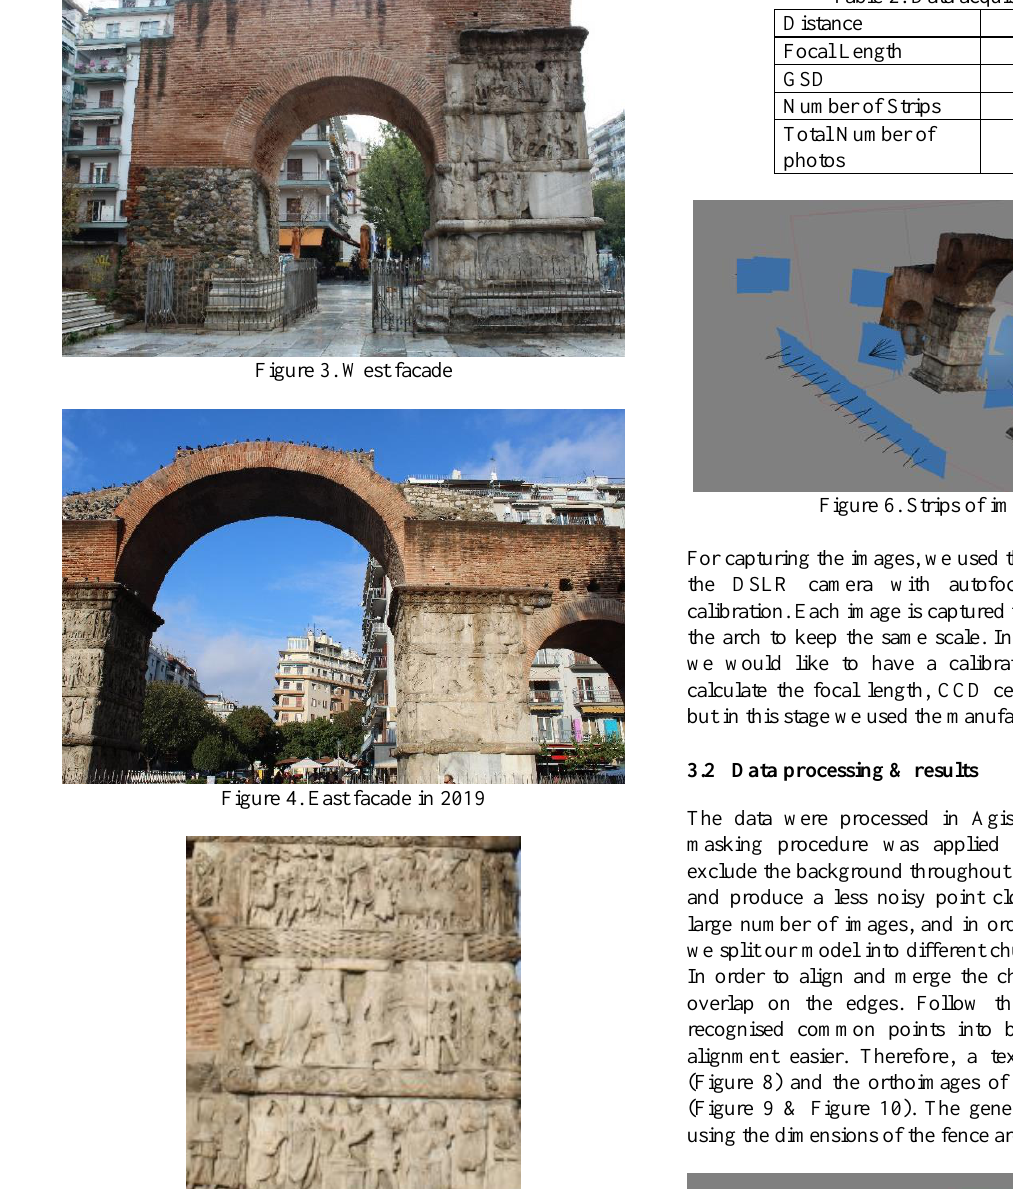
using the dimensions of the fence around the arch.